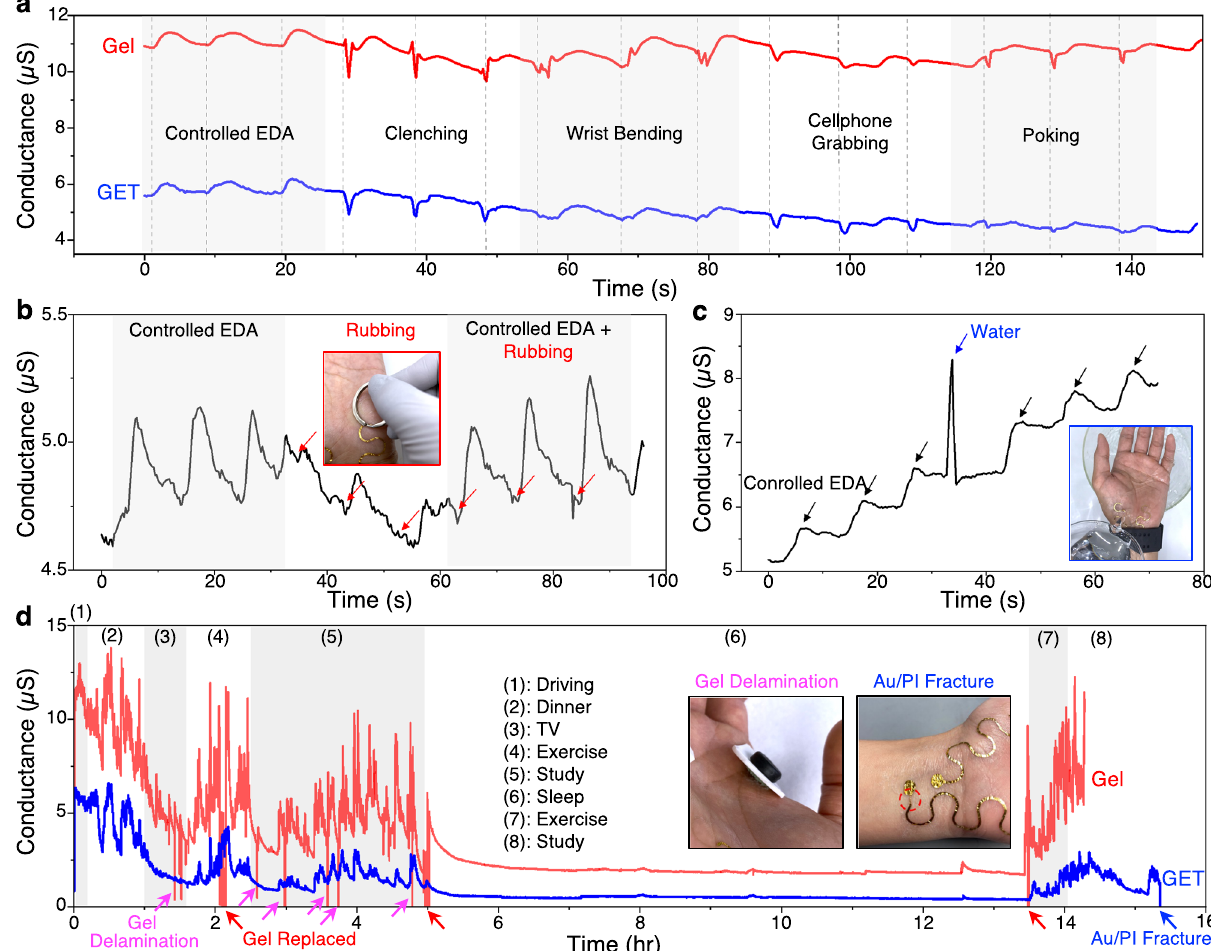
Fig. 6 | The wearability of wireless and ambulatory GET-based EDA sensor. a Comparison of the motion artifacts in GET- and gel-measured EDA signals when subjectedtohandclenching,wristbending,cellphonegrabbing,and fi ngerpoking. b Rubbing GET by a metal key ring only produces negligible artifacts compared withtheEDAsignal. c EDAquicklyspikesandrecoverswhenGETundergoesaquick